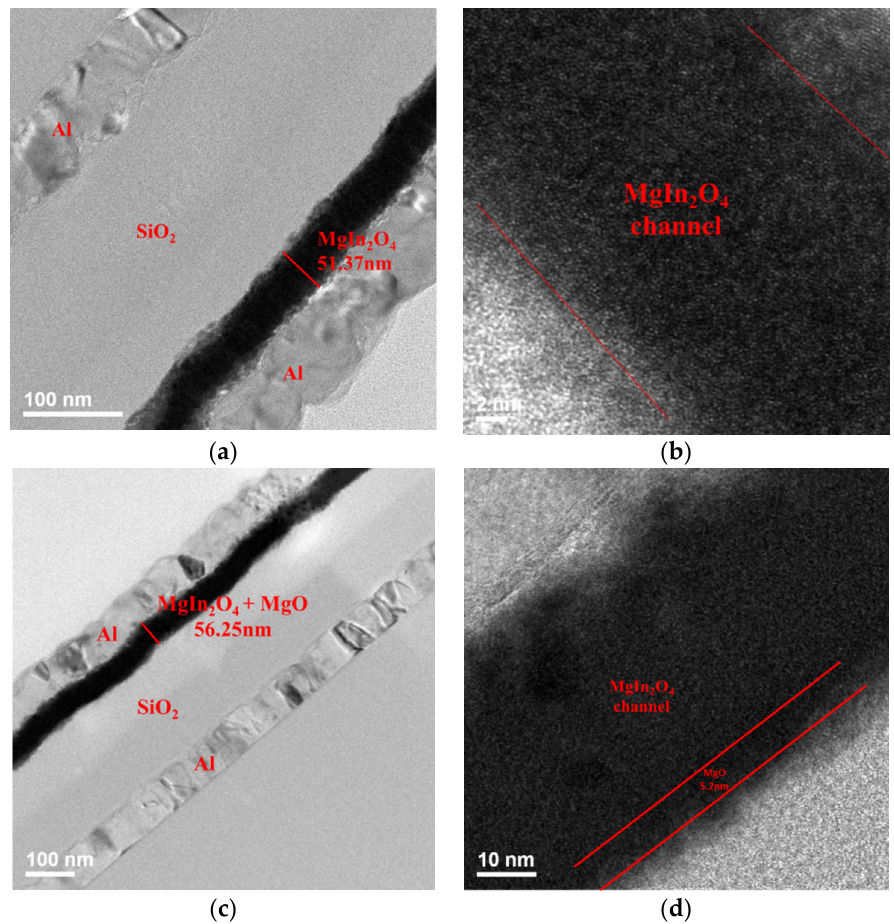
Figure 5. ( a ) Cross-section TEM and ( b ) HR-TEM images of the MIO TFT; ( c ) cross-section TEM and ( d ) HR-TEM image of the MIO TFT with MgO buffer layer.